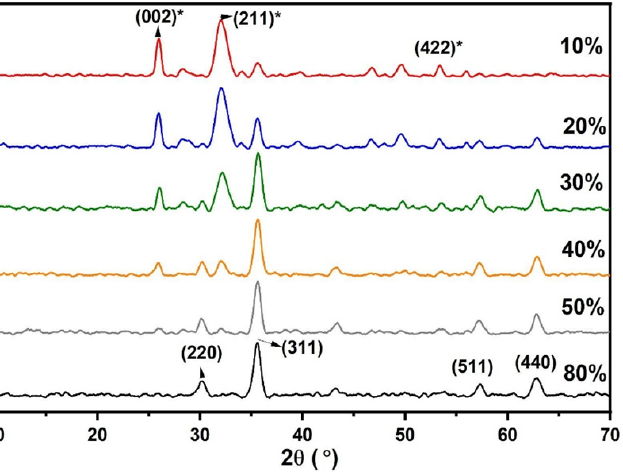
Figure 7. XRD pattern of nanocomposites with different ratios of SPION/HAp at 80 °C with pH 11. Symbol * corresponds to the HAp phase.